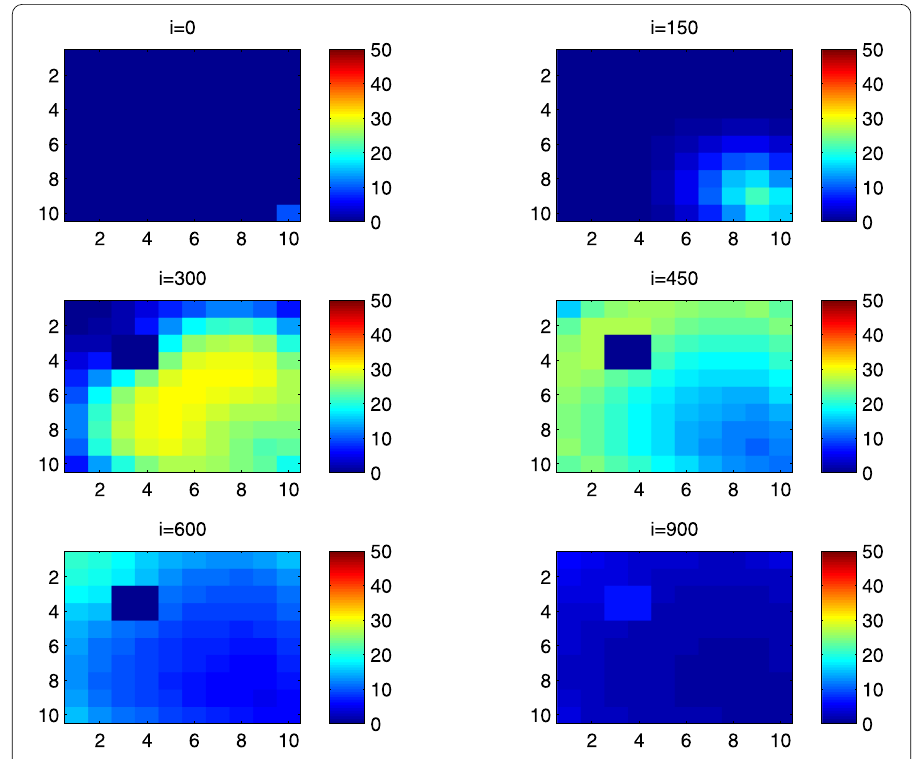
Figure 10 I Cpq behavior in the presence of optimal controls (11). The case when the disease starts from the corner C 11